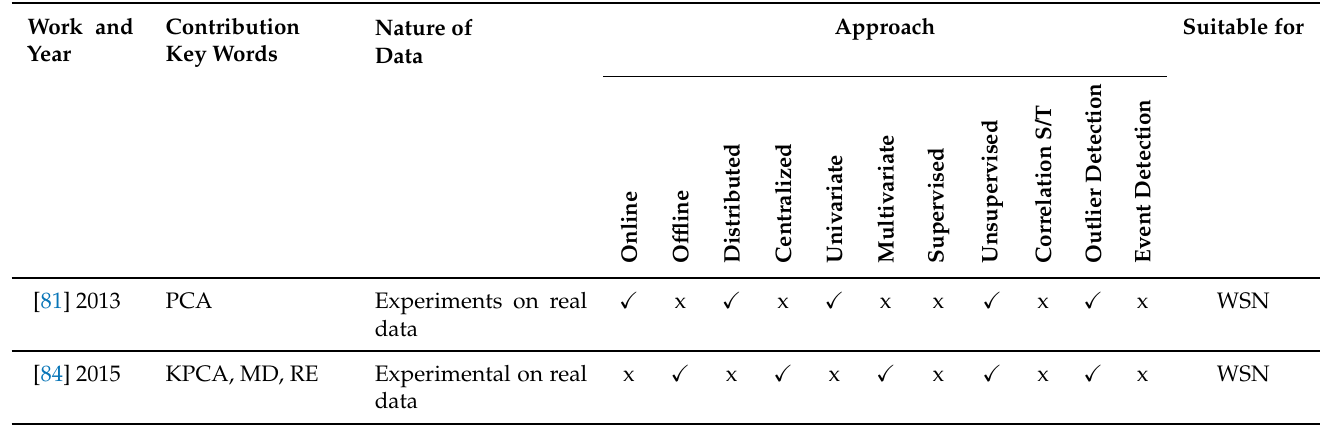
Table 7. Comparative Table of PCA-Based Techniques.